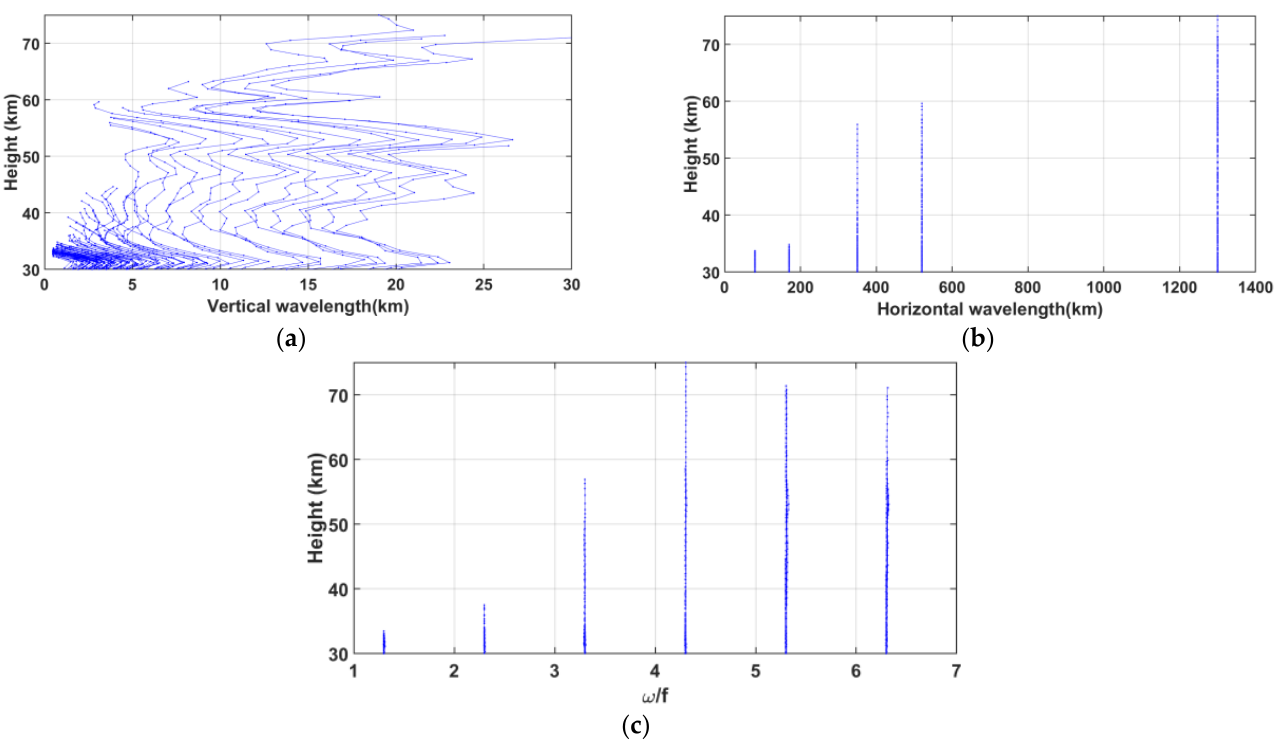
Figure 19. ( a ) Backward trajectories of ~90 individual modes from 9 October 2017 at 1200 UTC us- ing ERA5 data with 37-pressure levels; ( b ) altitude – horizontal distribution; ( c ) altitude –ω /f distri- bution; and ( d ) Meteosat 8 IR image (gray levels) on 9 October 2017 at 1100 UTC.